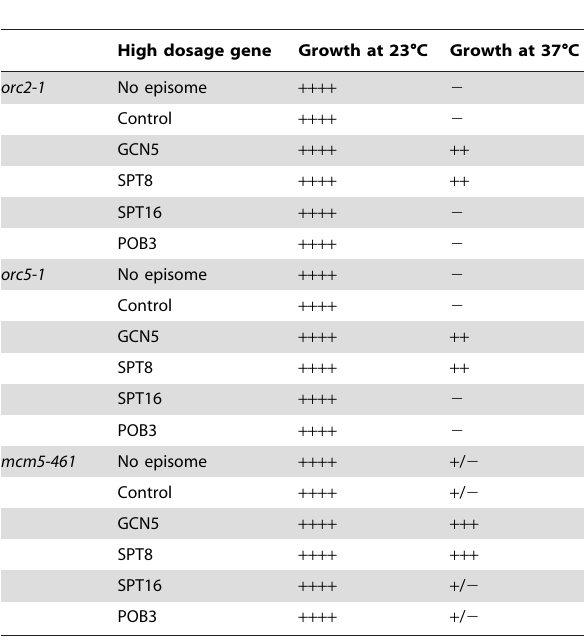
Table 2. High dosage of GCN5 and SPT8 partially suppress the Ts 2 phenotypes of replication factor